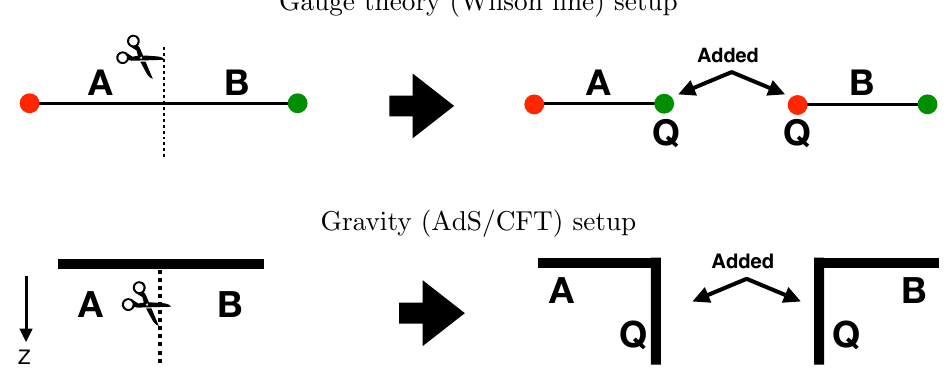
Figure 9 . Puri(cid:12)cation approach to de(cid:12)ne the subsystem A and B . The edge modes (states living on Q ) play a role of \puri(cid:12)ers" due to the correlations from gauge invariance. In the bottom (cid:12)gure, the labels A; B should be regarded as A (cid:0) ; B (cid:0) in (cid:12)gure